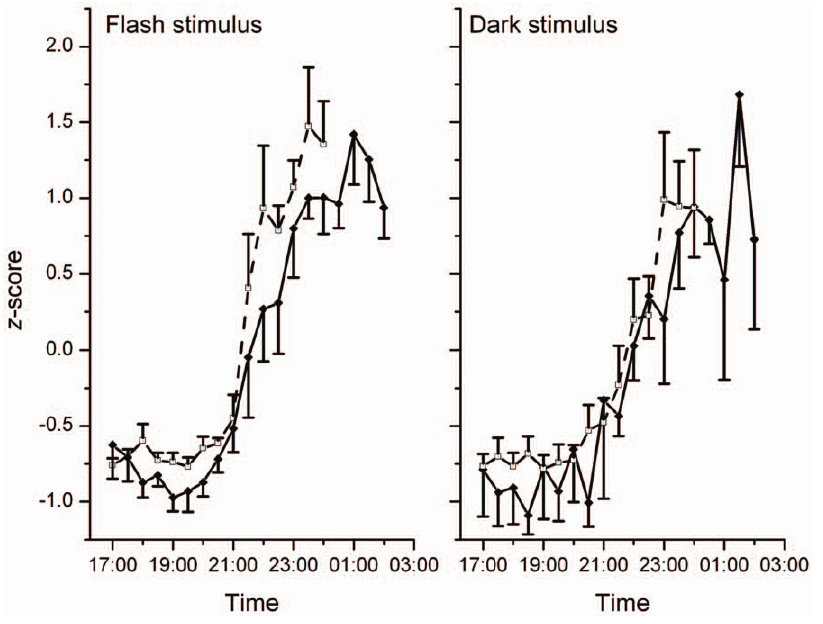
Figure 2. Phase shifts following the flash or dark stimuli. Average salivary melatonin profiles pre- (dashed lines) and post- (solid lines) exposure to either a series of flashes (left panel, 60 2-ms flashes, 1 per minute) or continuous darkness (right panel) for an hour are shown. Data were z -score transformed prior to averaging and aligned to a habitual bedtime of 24:00.